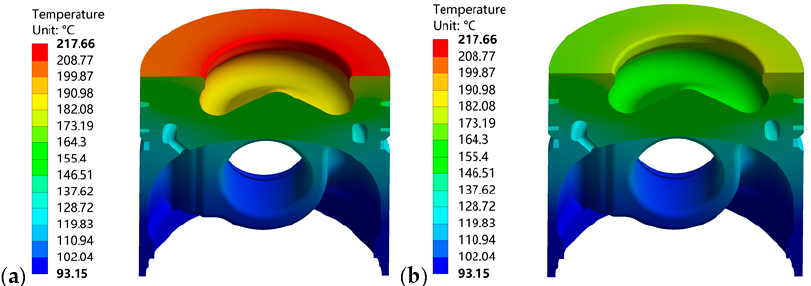
Figure 11. Temperature field of TBC piston: ( a ) the temperature field of the thermal barrier coating piston; ( b ) the temperature field of the thermal barrier coating piston substrate.